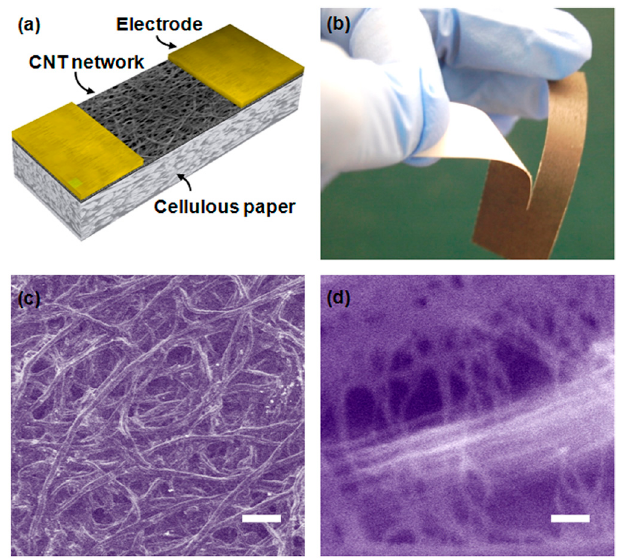
Figure 20. ( a ) Schematic illustration of the humidity sensor built on a cellulose paper substrate; ( b ) networks of CNTs on the paper showing that the device is flexible and custom-cut; ( c ) SEM image of the cellulose paper (scale bar 250 µm); and ( d ) magnified image of the cross-linked CNTs (scale bar 100 nm) [148].